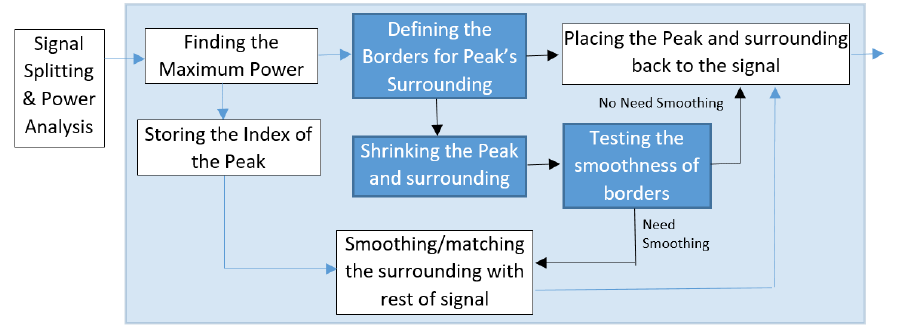
Figure 11. The PSI algorithm iteration loop block diagram